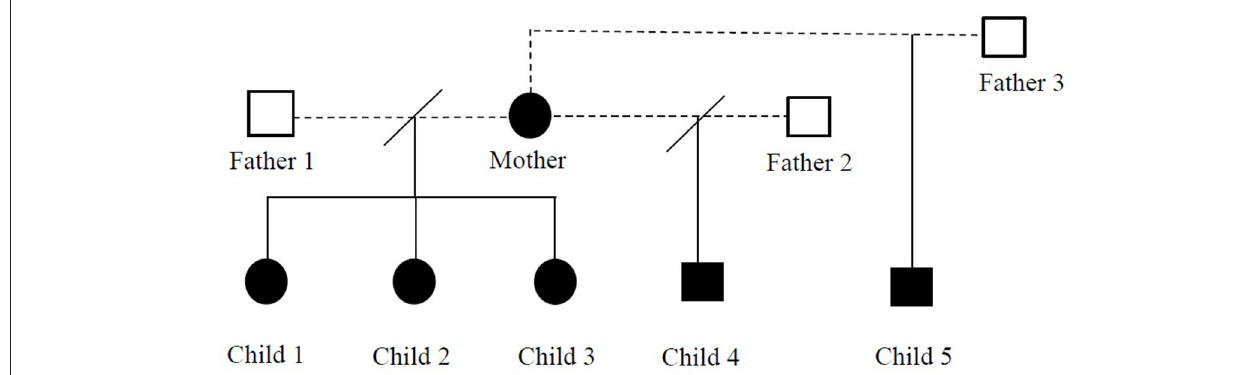
FIGURE 1 | Pedigree chart of the reported family with Potocki-Lupski syndrome.